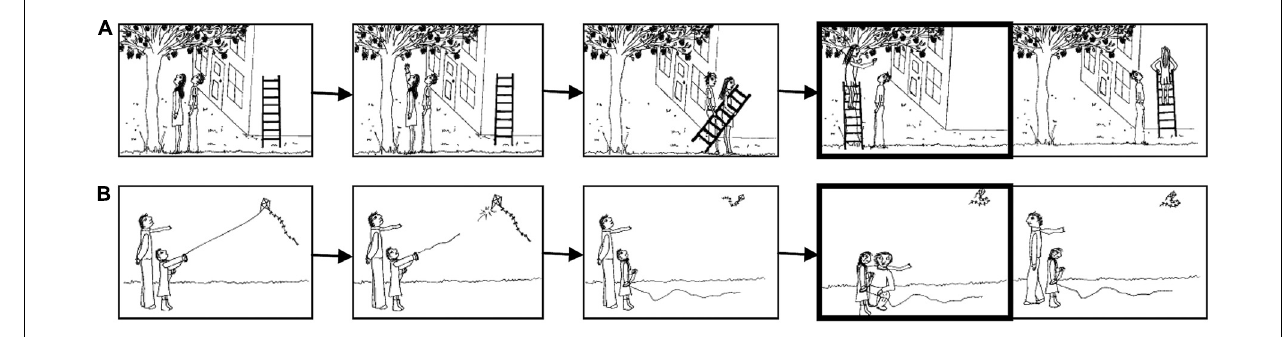
FIGURE 1 | Five pictures of one cartoon story for cognitive ToM (A) and affective ToM (B). The first three pictures appeared on a computer screen consecutively, the last two pictures appeared